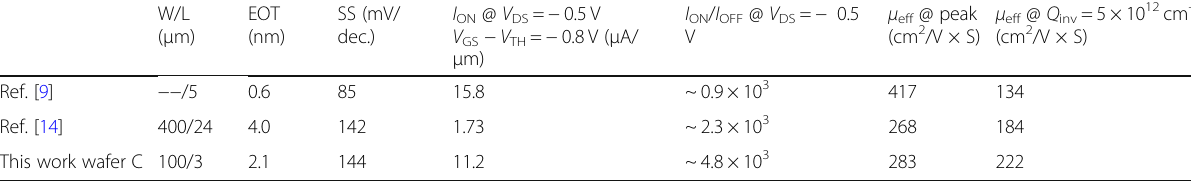
Table 2 Key device performance of Ge pMOSFETs in this work vs. other published results with